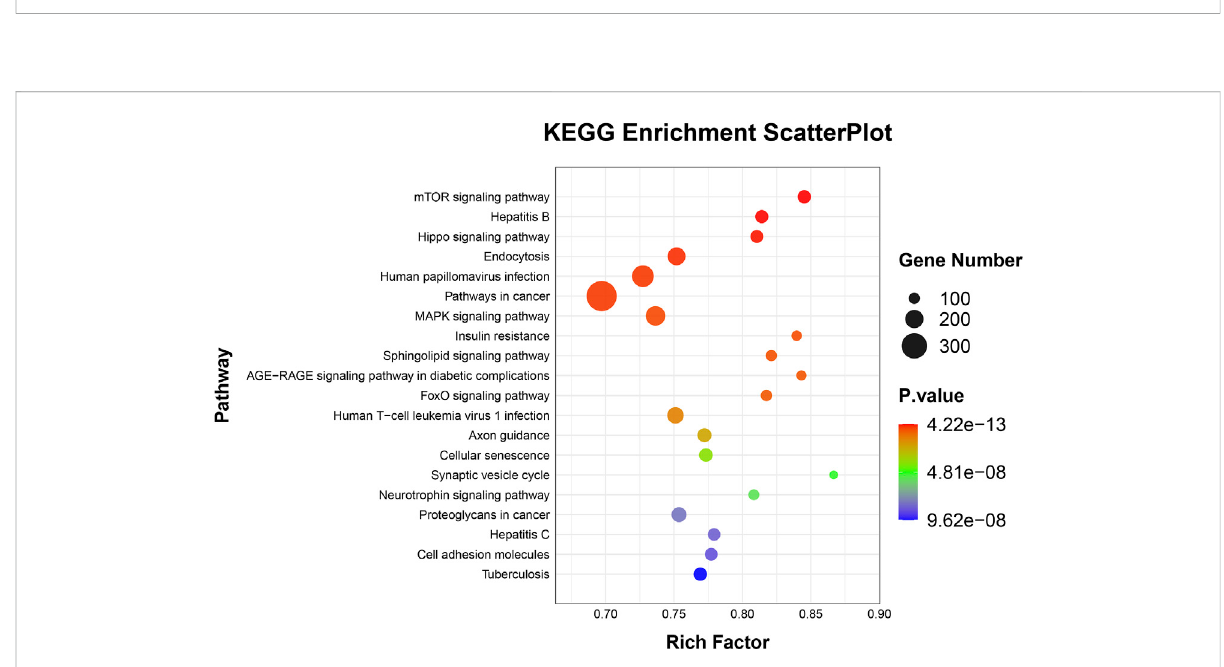
FIGURE 10 Target genes of miRNAs expressed signi fi cantly differentially between the teo MCC-Exo groups were enriched in KEGG pathways. Bubble size represents the number of differential genes annotated for a certain pathway. The redder the color, the smaller the signi fi cance and higher the enrichment